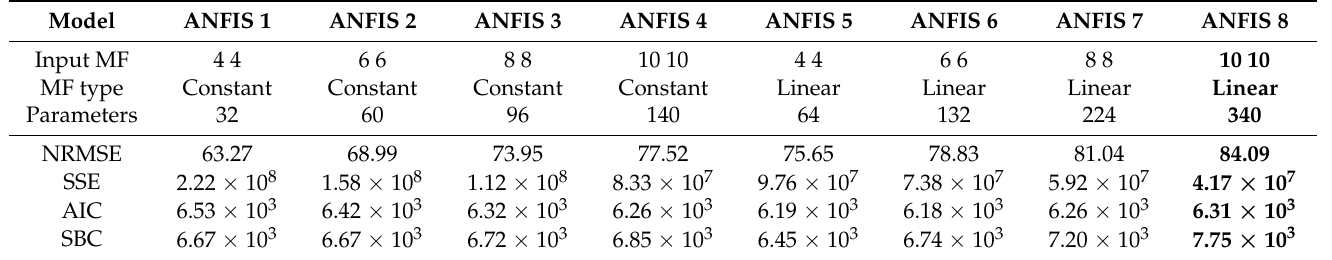
Table 7. Overview of the parameters of the created ANFIS models and performance metrics of the DMSP-40 muscle validation results.